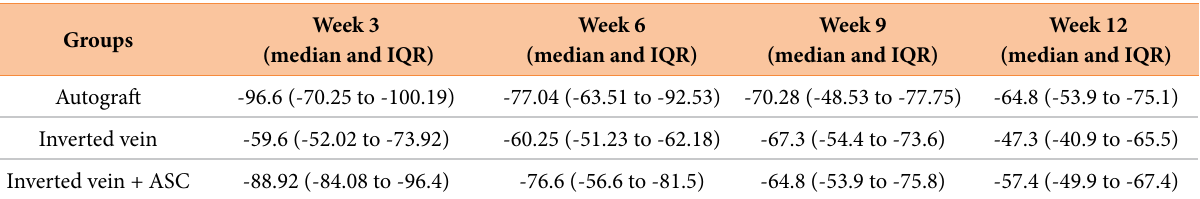
Table 1 - Change in the sciatic function index in the autograft, inverted vein, and inverted vein + ASC groups in relation to pretreatment condition and according to the moment of assessment. Values described as median and IQR.